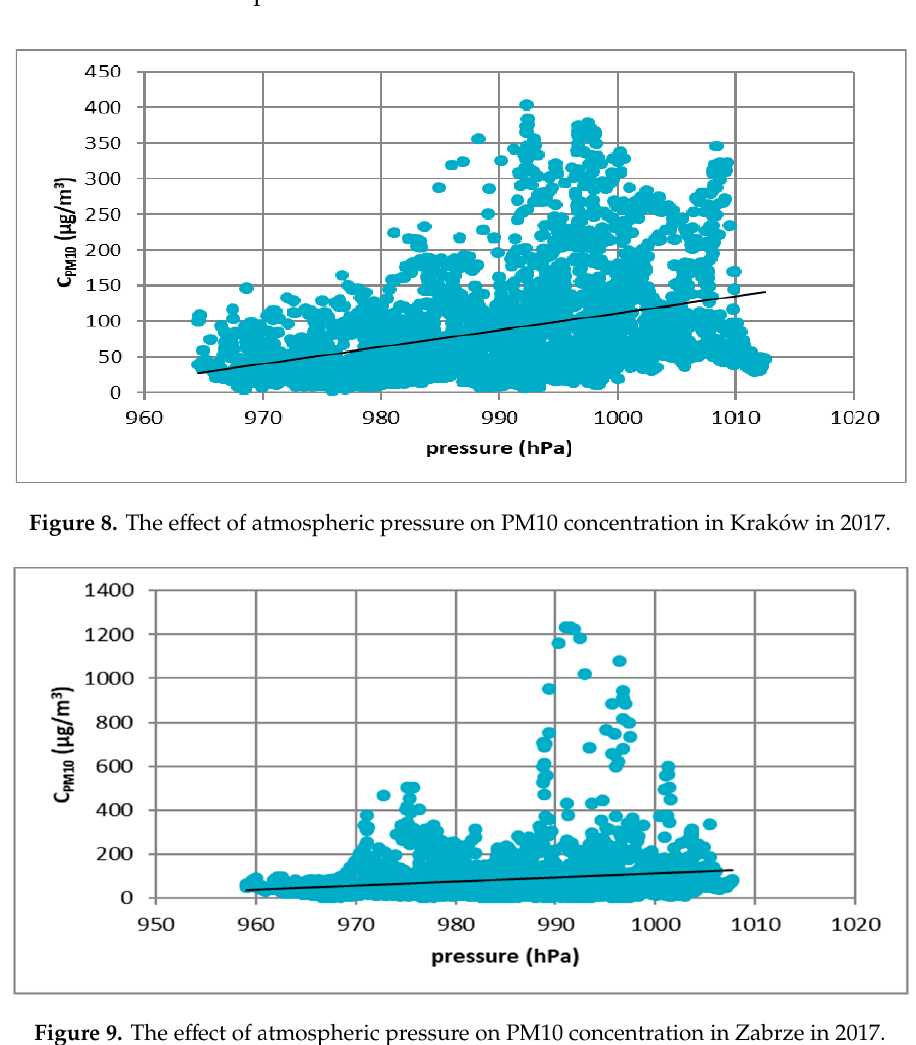
Figure 7. The effect of atmospheric pressure on PM10 concentration in Ł ód ź in 2017.